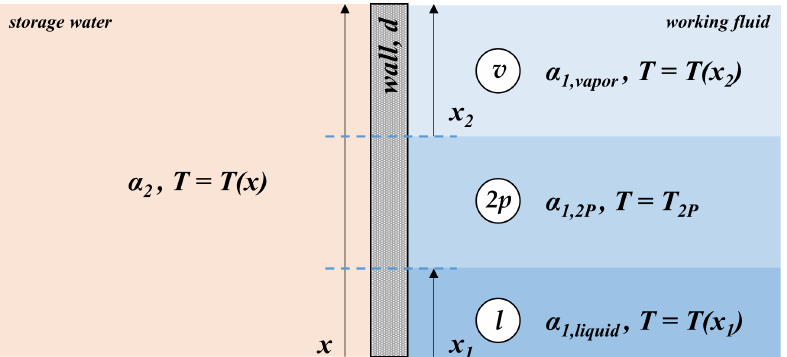
Figure 2. Principle of the analytical approach: dividing the heat exchanger into three regions: pre-heating/sub-cooling ( l ); evaporation/condensation ( 2p ); super-heating/pre-cooling ( v